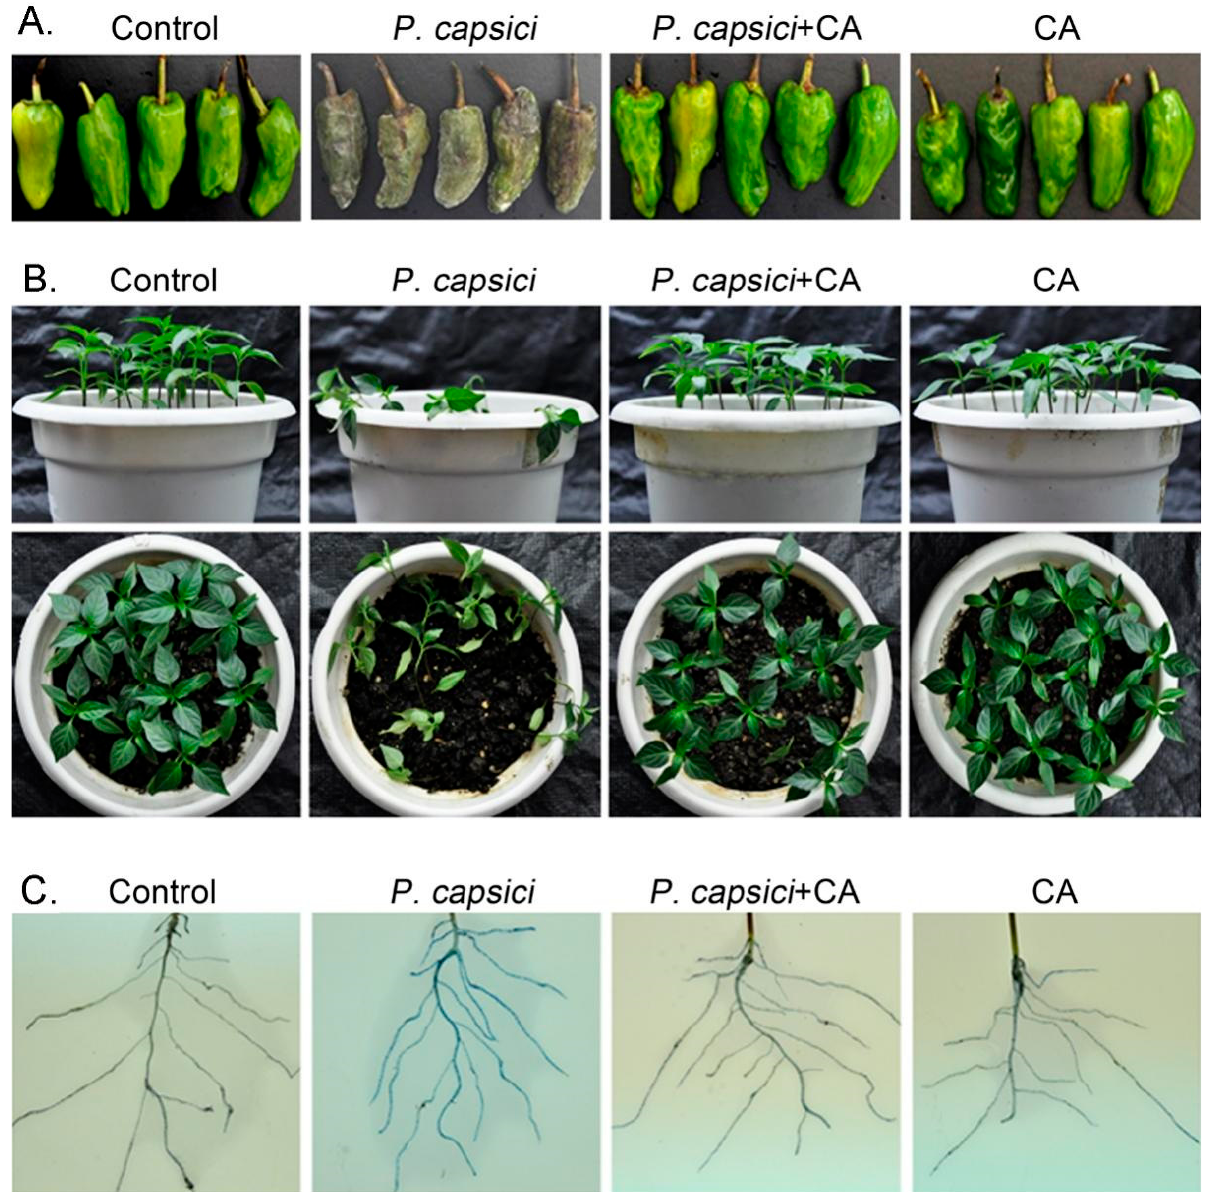
Figure 1. Inhibition of Phytophthora blight by CA on pepper seedling and fruit/ ( A ) Inhibition effect of Phytophthora blight by CA (1 mM) on pepper fruit and pepper seedling after 3 h inoculation with zoospores suspension (1 × 10 5 spores/mL). ( B ) Pepper seedlings were treated with zoospore suspensions supplemented with or without 1 mM CA. ( C ) Trypan blue staining with pepper roots treated with zoospore suspensions supplemented with or without 1 mM CA.